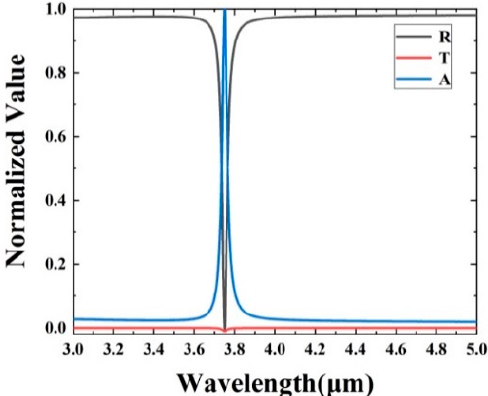
Figure 2. Spectrogram of reflectance (R), transmittance (T), and absorbance (A) under the normal incidence of symmetrical Si grating.